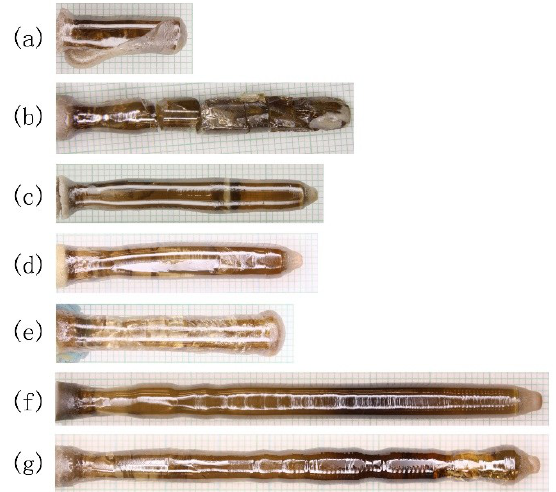
Figure 1. Pictures of as-grown Y 2 Ti 2 O 7 crystals. As-grown crystals shown in ( a – g ) were obtained under conditions listed in Table 1, respectively. The tips of as-grown crystals are on the right side in photos.